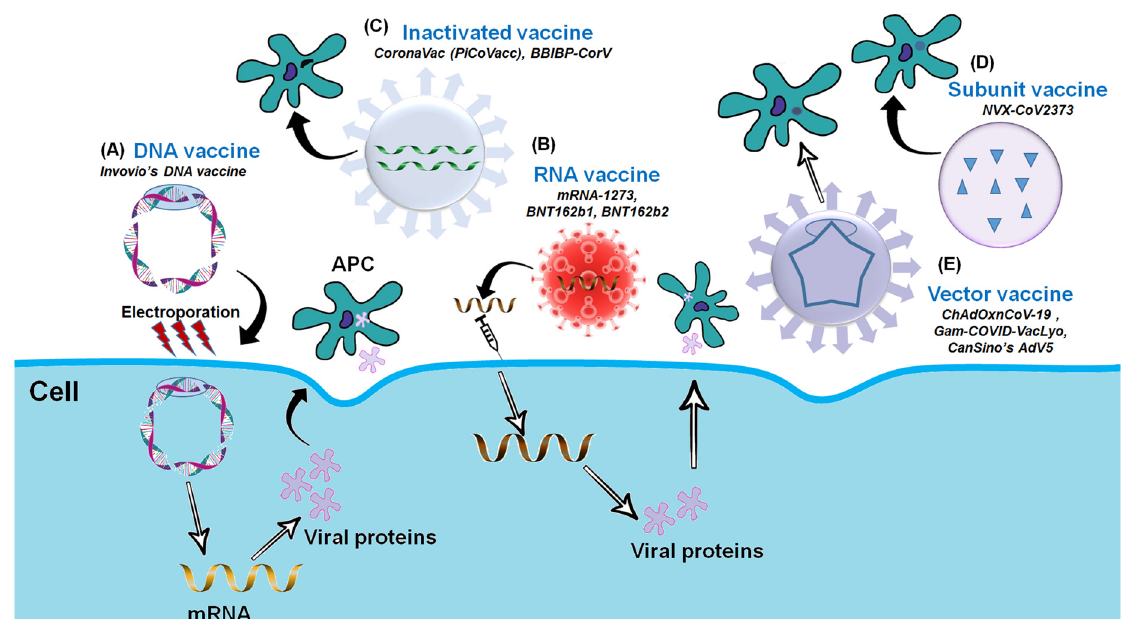
Figure 2. Platforms for the COVID-19 Vaccine Development. ( A ) DNA vaccine: Plasmid DNA expressing S protein. ( B ) RNA vaccine: mRNA-based (RBD of S-protein). ( C ) Inactivated vaccine: Inactivated whole SARS-CoV-2. ( D ) Subunit vaccine: Recombinant S-protein and ( E ) Vector-based vaccine: Replicating or Non-replicating viral vector used for the delivery and expression of S protein. Table 1. Current COVID-19 vaccines in clinical trials.